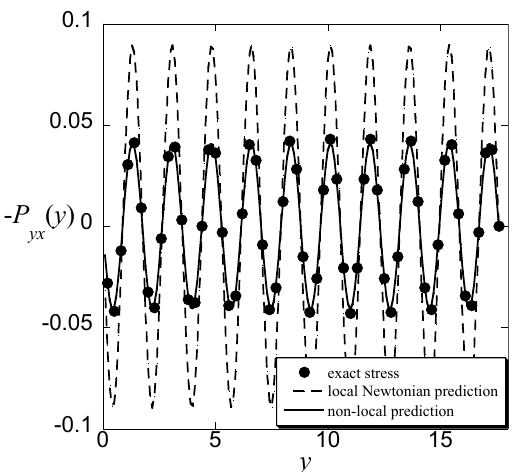
P yx ) predictions using the simple Newtonian constitutive equation (dashed Figure 5. Shear stress ( − line), and the nonlocal constitutive equation (solid line) compared with the exact stress (filled circles) for a simple liquid [36] where the y -position is expressed in units of the Lennard–Jones potential distance parameter σ